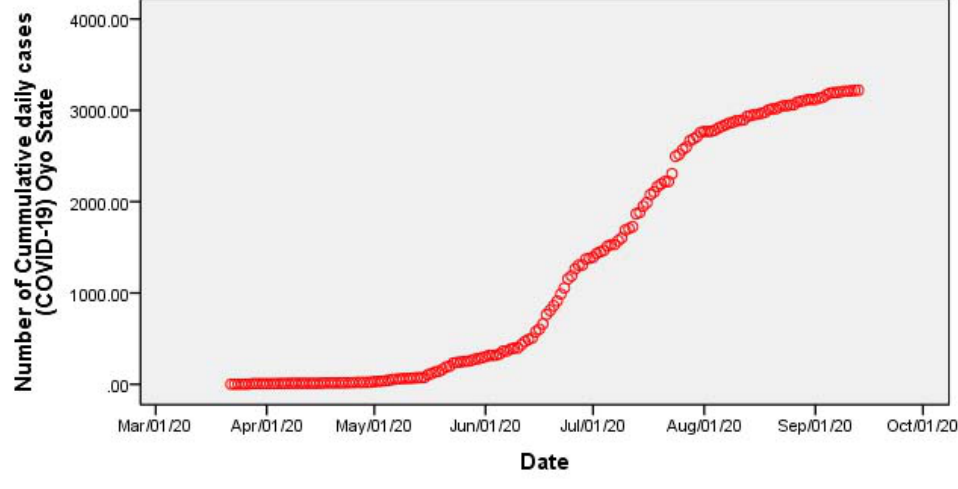
Figure 1. Cumulative daily COVID-19 cases in Oyo state, Nigeria (March 22 – September 13,